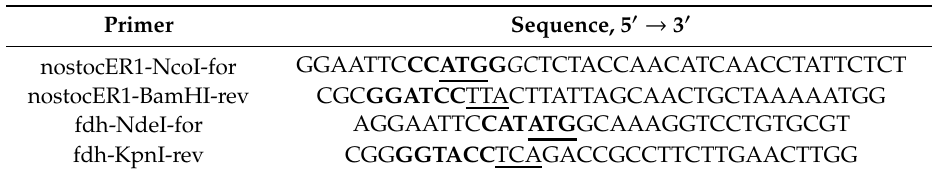
Table 3. Primers used for amplification of the nostocER1 and fdh genes. The 5 (cid:48) → 3 (cid:48) sequences with the restriction site shown in bold and the start / stop codon underlined are